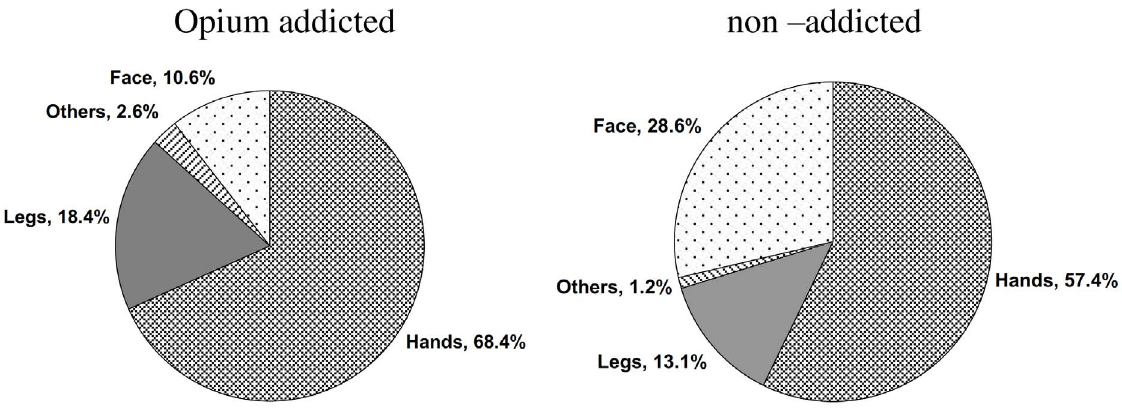
Figure 2. Location of the cutaneous leishmaniasis lesions in opium addicted and opium non – addicted cohorts.